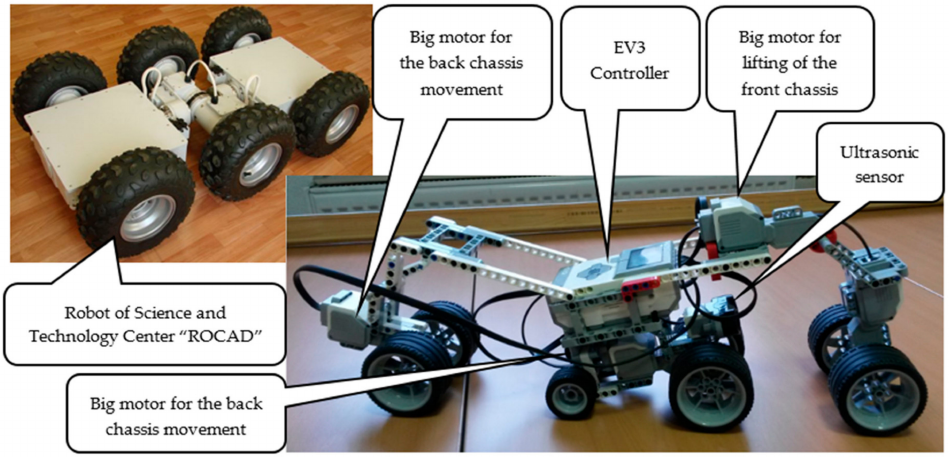
Figure 6. The manipulating robot prototype.